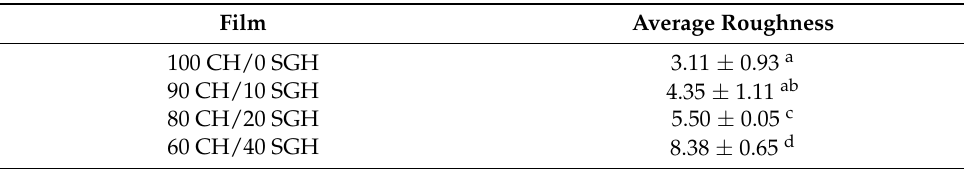
Table 2. Roughness values estimated by the three-dimensional images of chitosan (CH) with squid gelatin hydrolysate (SGH) films surface obtained with AFM 1 .